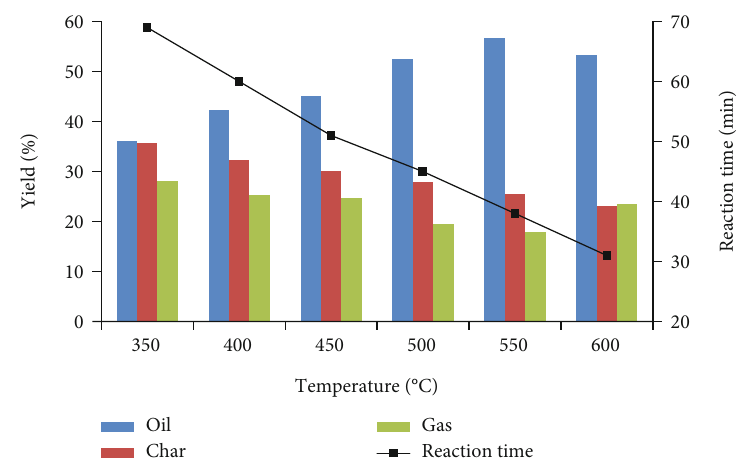
Figure 5: E ff ect of temperature on yields of WT thermal pyrolysis.